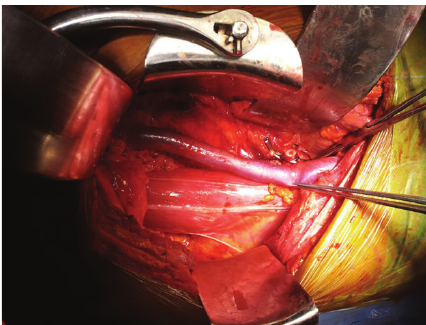
Figure 1: Intraoperative picture of right sided transplant fossa with complete absence of iliac arterial system.